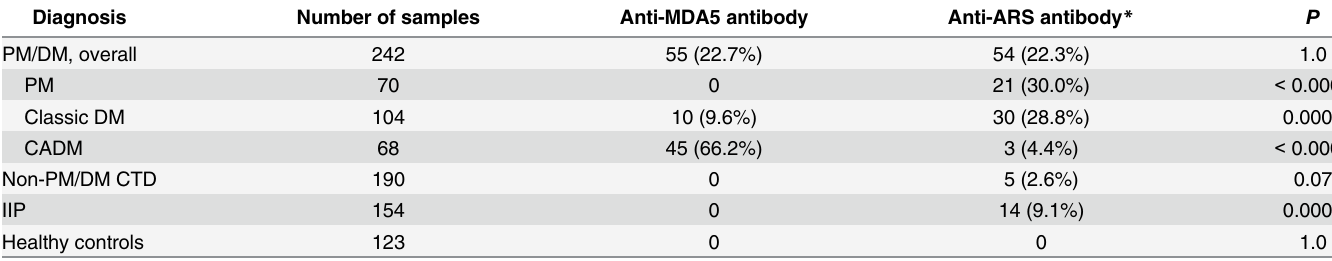
Table 1. Frequencies of anti-MDA5 and anti-ARS antibodies detected by ELISA.